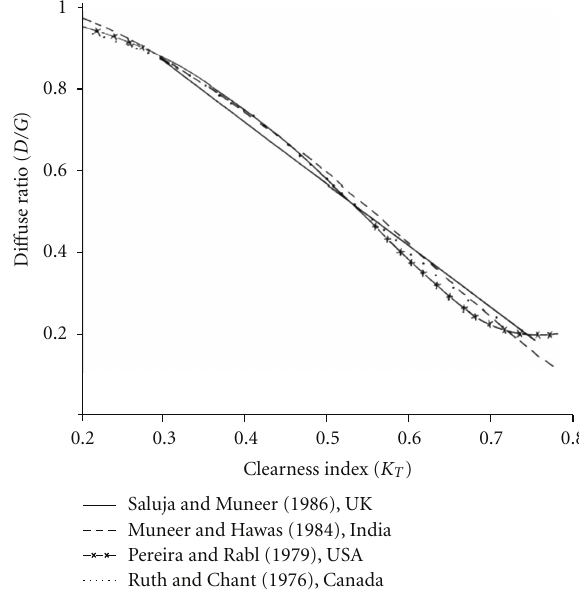
Figure 2: Regression curves of daily di ff use ratio—worldwide locations [37].